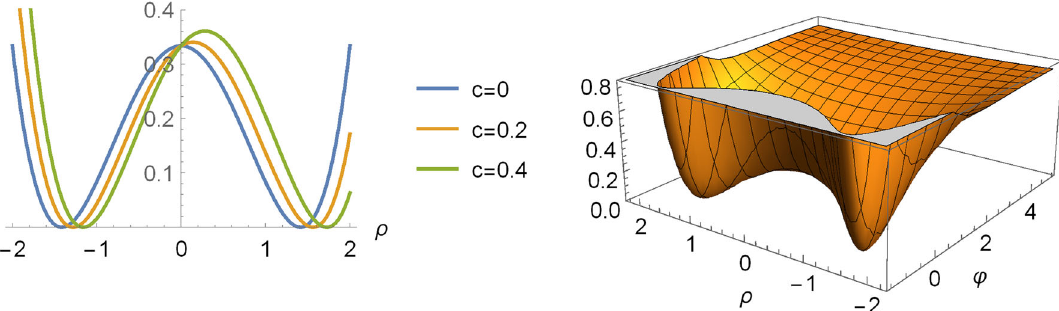
Fig. 1 The single-field scalar potential U / M 2 in Eq. (15) for some values of the parameter c (on the left), and the two-field scalar potential V / M 2 in Eq. (14) for c = 0 (on the right). The other parameters used are b = − f = 1